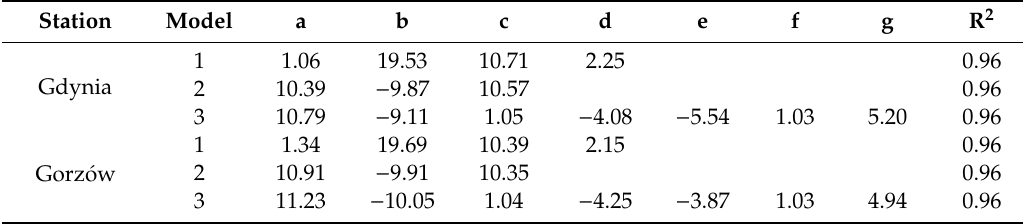
Table 2. Coe ffi cients of models (1)–(3) for analyzed